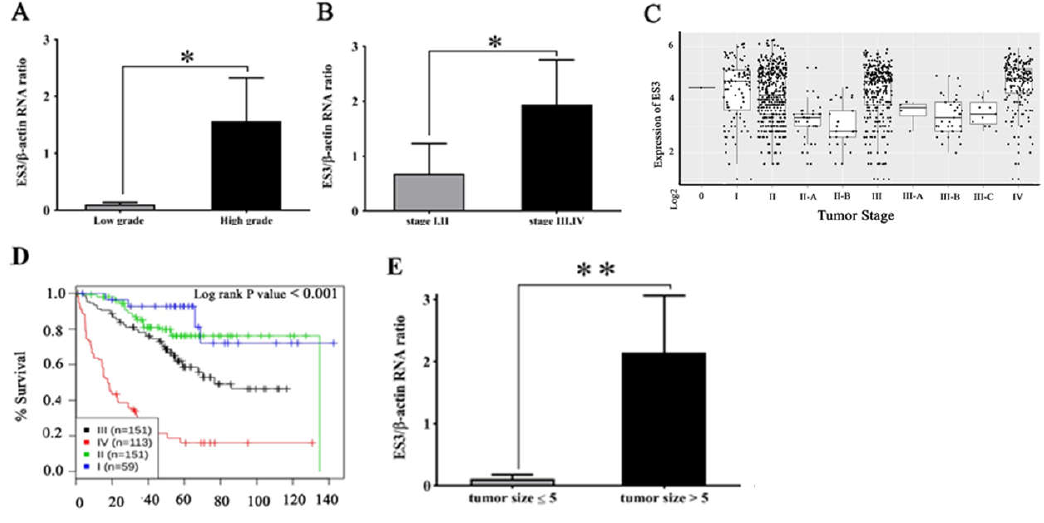
Fig. 2. LncRNA ES3 is significantly overexpressed in coordinate to the grade/stage increasing in CRC tissues and its expression was dramatically related to tumor size: A) The expression analysis of lncRNA ES3 in CRC tissues demonstrated that its expression was significantly overexpressed in both high-grade (*p < 0.05); B) and high-stage CRC tissues (*p < 0.05); C) Diagram showed the ES3 expression level in multi-stages of colorectal cancer on TCGA database.; D) According to the TCGA database, the Kaplan-Meier method was used to analyze the correlation between ES3 expression in different stages of CRC and the survival rate of patients. This data showed that ES3 expression was significantly associated with survival rate in higher stages of CRC (*p < 0.001); E) Our RT-qPCR results demonstrated that the expression of lncRNA ES3 dramatically elevated along with increasing the CRC tumor